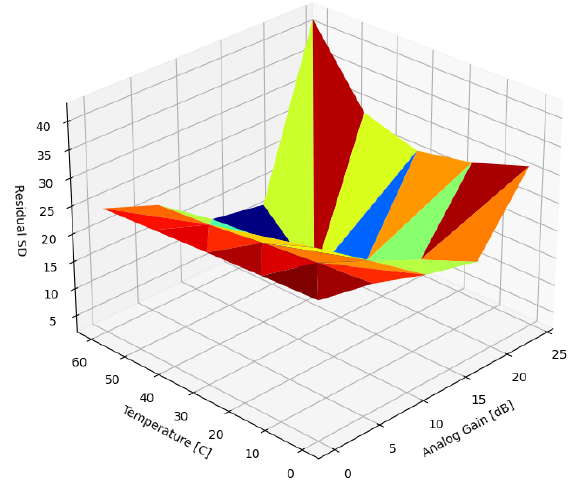
Figure 10. Residual SD of DSNU with a single, static